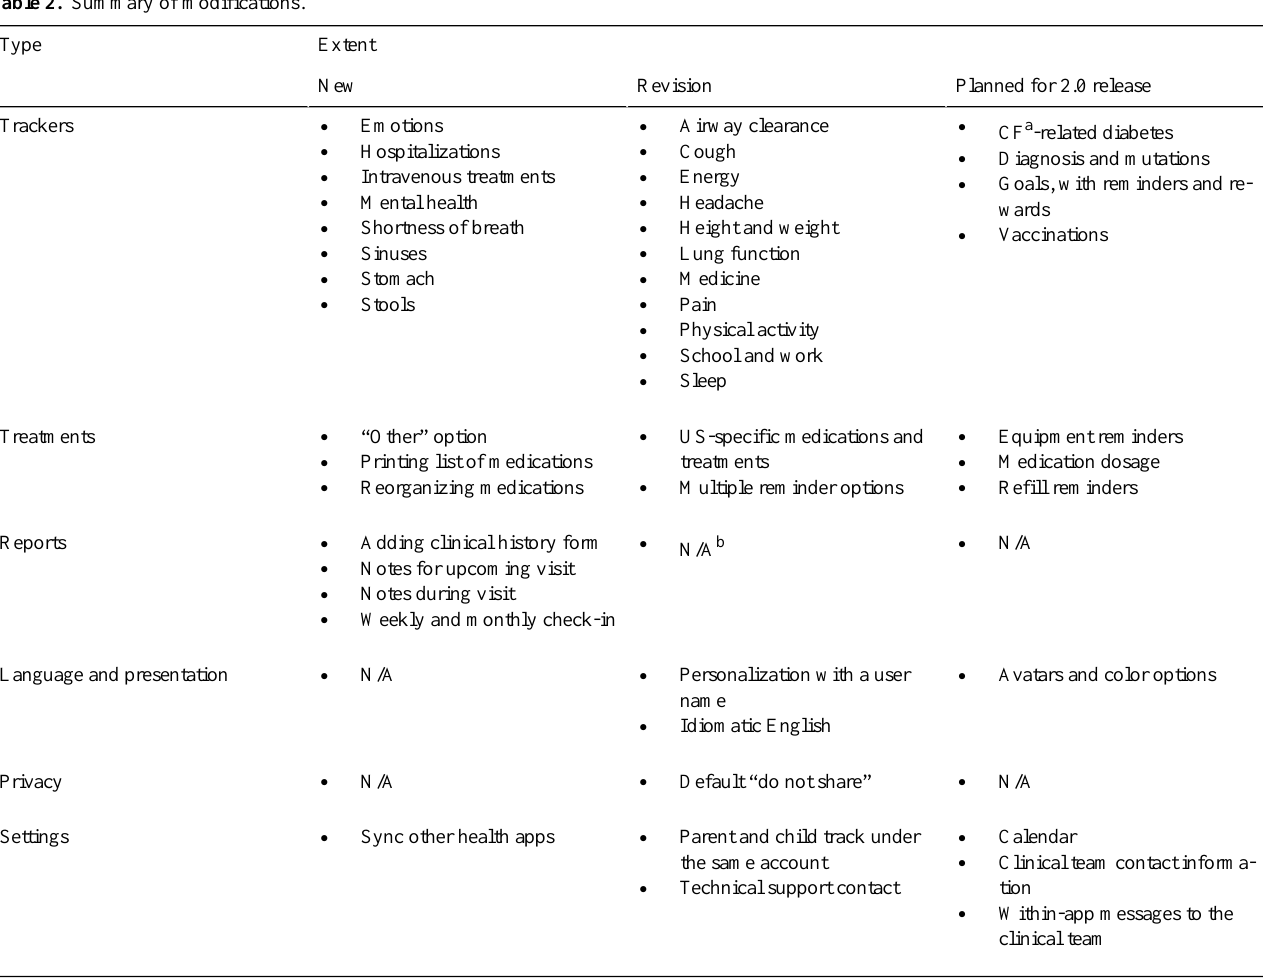
Table 2. Summary of